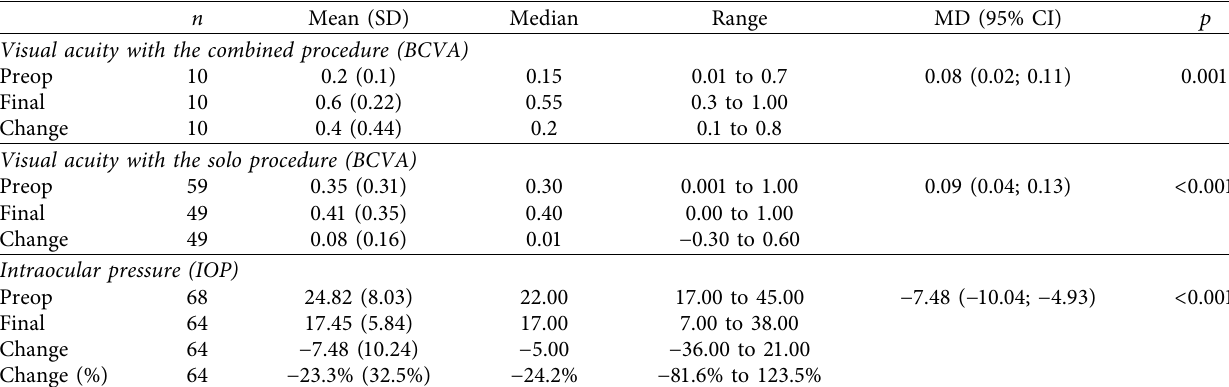
Table 2: Visual acuity (decimal notification) and interocular pressure mean values, median values, standard deviations, and range before